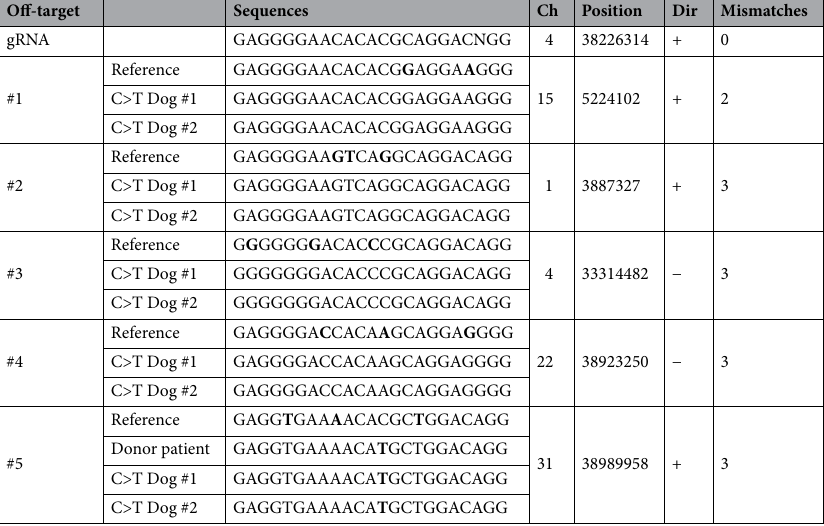
Table 2. Sequencing analysis of potential off-target loci in gene-corrected dogs. Letters in bold indicate mismatches with the gRNA sequence. Ch: chromosome number; Dir: direction; Mismatch: number of